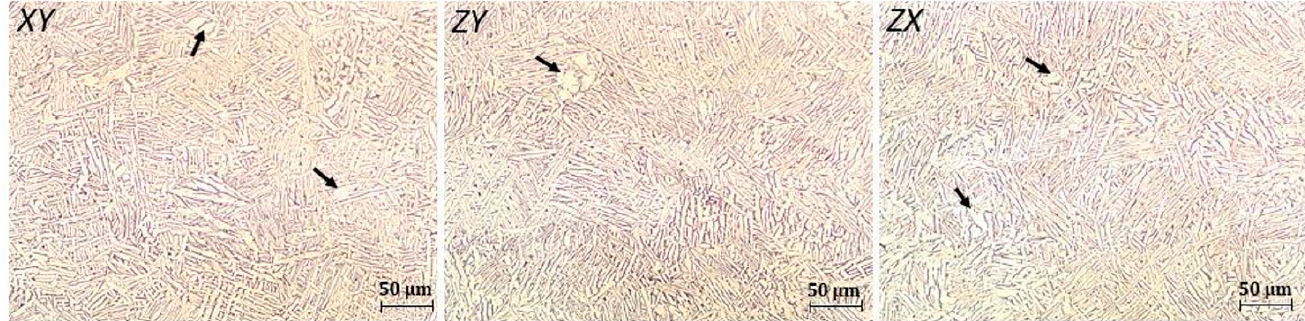
Figure 5. Optical microscope images for XY , ZY , and ZX orientations of Ti6Al4V specimens produced by the L-PBF process and followed by two-stage heat treatment. The arrows indicate globalized α grains (light) where β is indicated by dark marks.